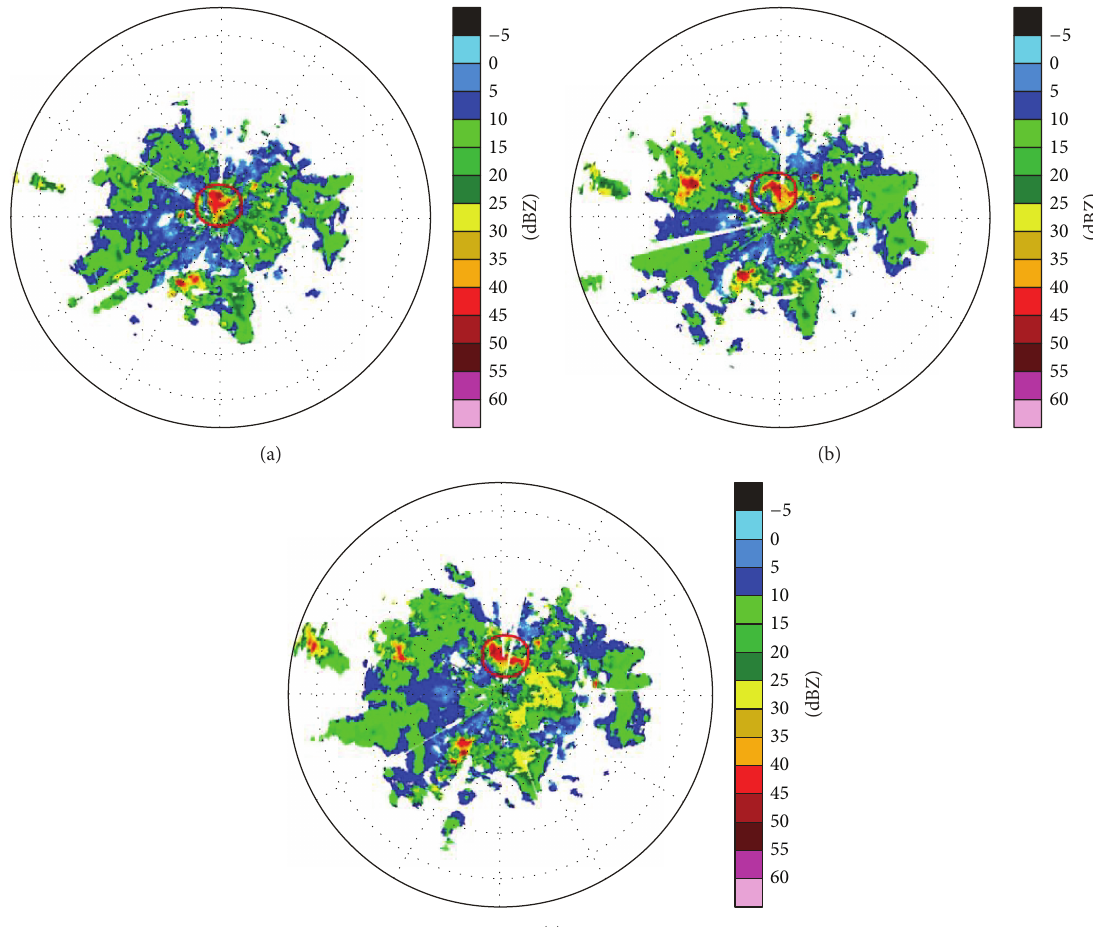
Figure 8: WUHN station Doppler radar basic reflectivity (inclination: 0.5 ∘ ; range: 230 km). Data were collected at the following times (Beijing times): 8:14 p.m. (a); 8:26 p.m. (b); 8:38 p.m. (c).